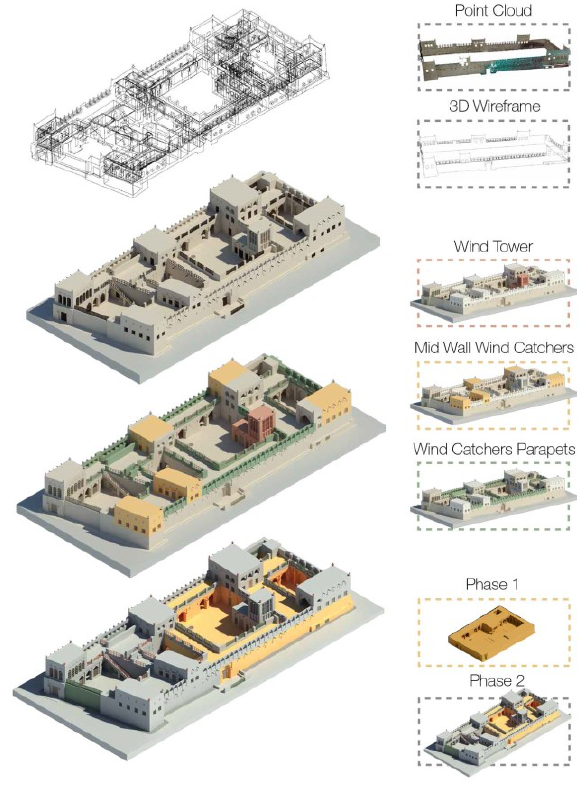
Figure 7. Different HBIM-based analysis realised for the house of Shaykh Isa bin Ali